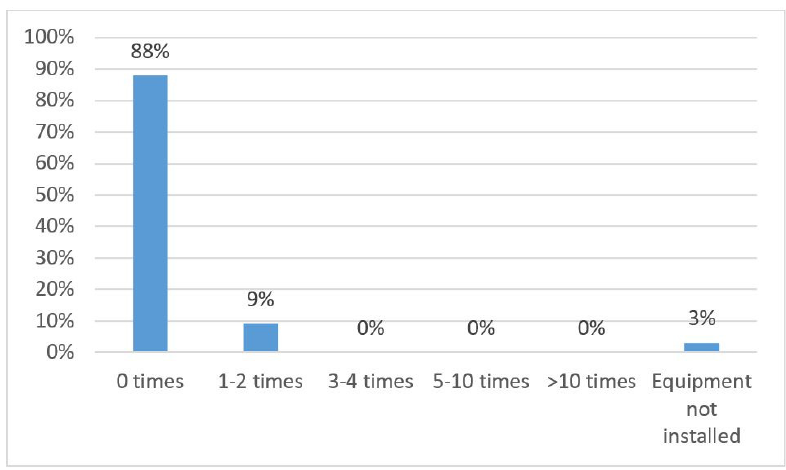
Figure 6. Frequency of use of the MF/HF radio telex.